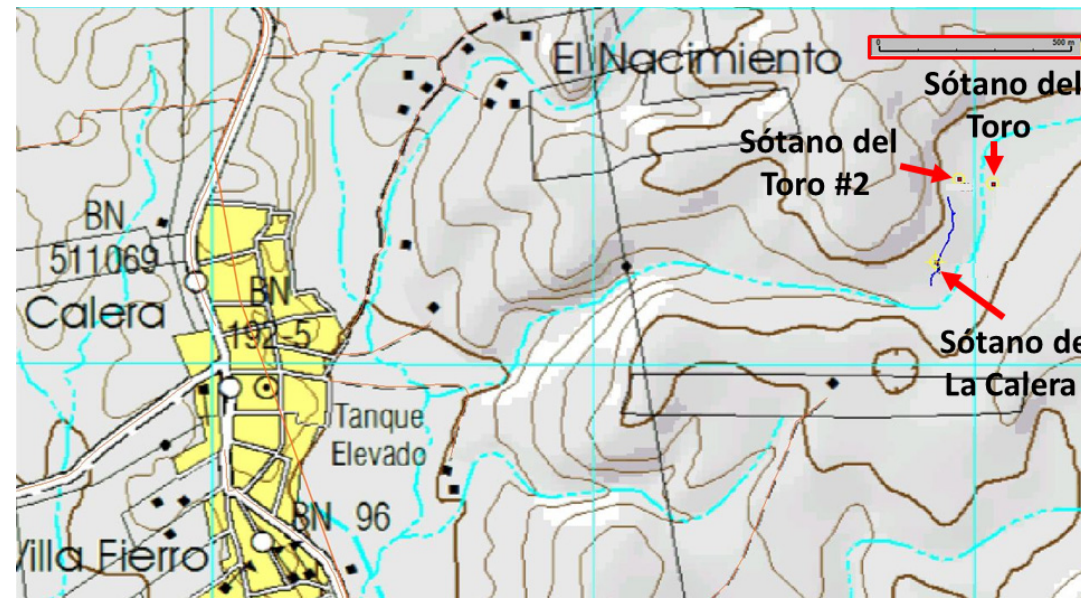
Figure 8. Topographic map showing the close proximity of Sótano del Toro, Sótano del Toro #2 and Sótano de La Calera. Also shown in the map are the town of La Calera, from which the cave receives its name, and the town of El Nacimiento, which means “spring”. This spring may be one of the potential sources of surface fish found in the cave system. In dark blue is the line plot of Sótano de La Calera. Notice that it is heading directly towards Sótano del Toro #2. While sumps prevent passage without diving gear, these three caves likely form a single hydrologic system, and fish can move from one to the other during the rainy season. Modified map from INEGI data, F14D11, El Pujal, 1:50,000 topographic sheet.